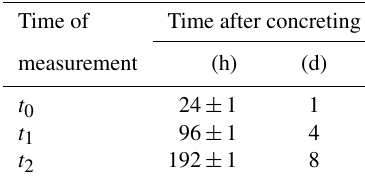
Table 4. Test times of the shrinkage tests. Time of